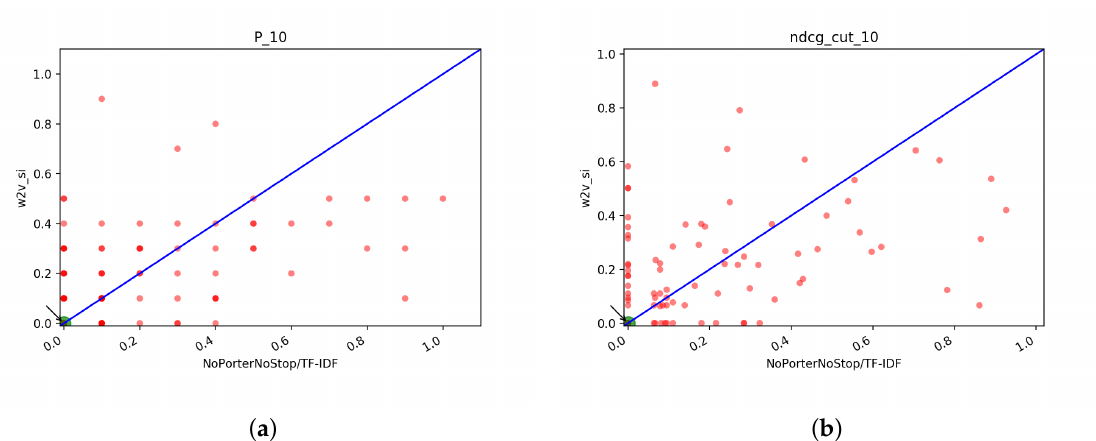
Figure 19. Scatter plots of NoPorterNoStop/TF-IDF vs. w2v-si: ( a ) P@10, ( b )